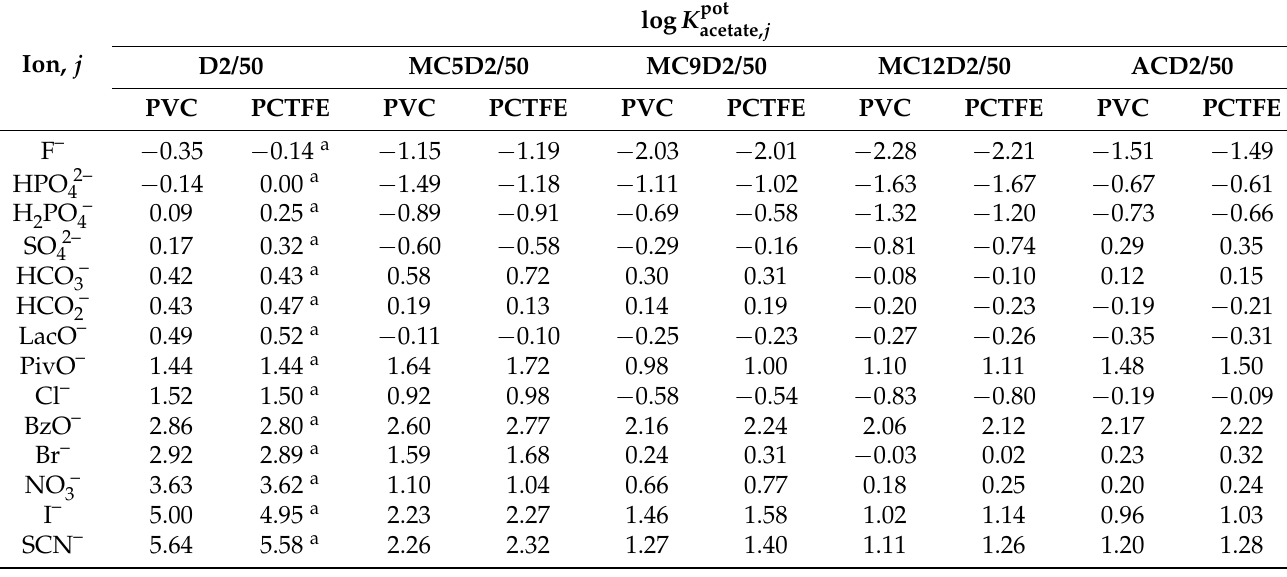
Table A7. Average potentiometric selectivity coefficients determined with the separate solution method ( a i = a j = 10 − 2.05 M) for sensors with membranes containing 2wt.% ionophore, 50mol.% (relative to the ionophore) TDMACl, and DOS as the plasticizer. The number of measurements and the number of sensors were n = 1 and k = 2, respectively, unless noted otherwise. See Table A8 for standard deviations. See Table 1 for membrane compositions.